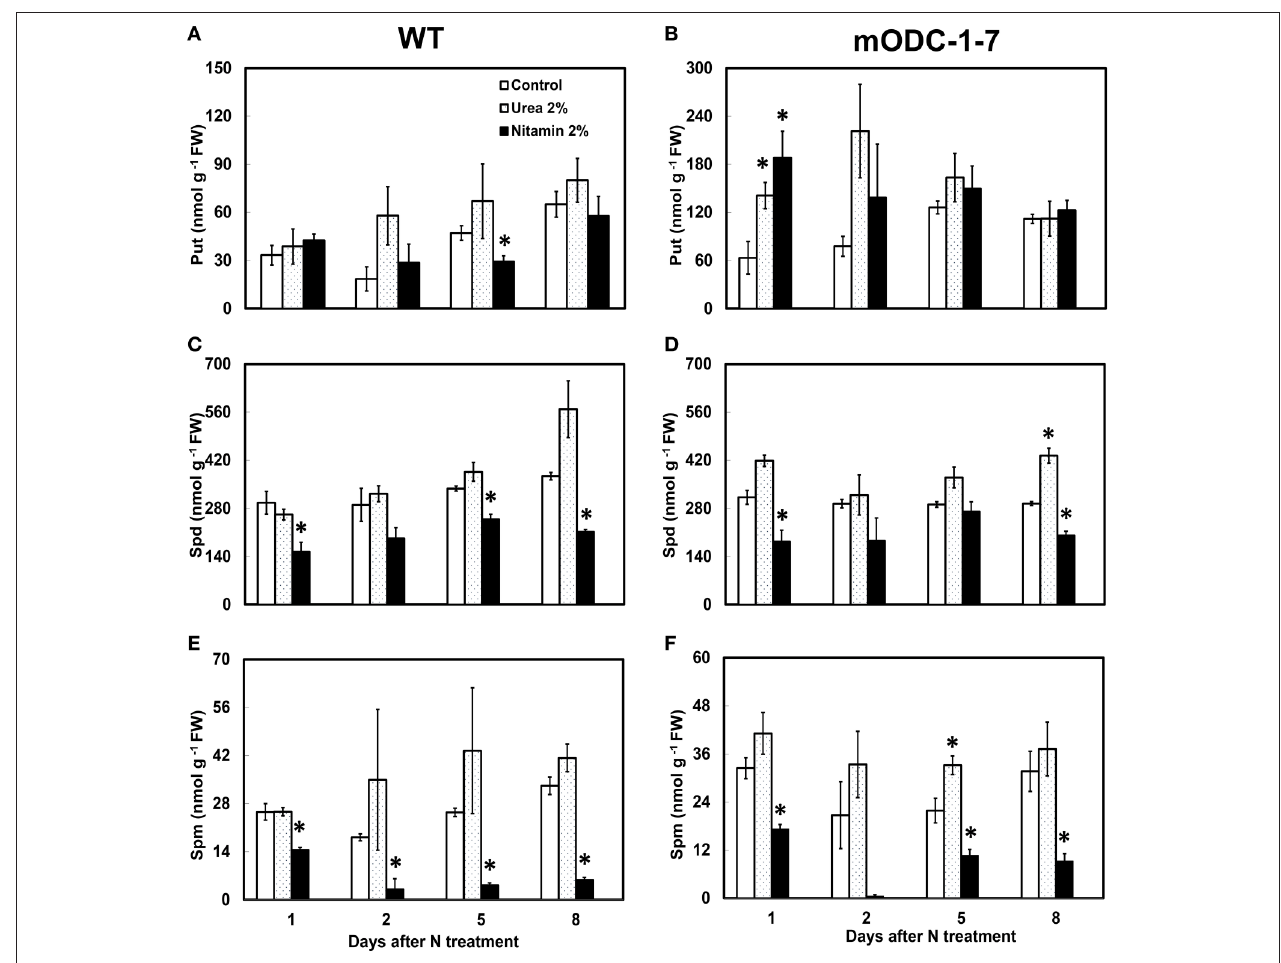
FIGURE 7 | Effect of foliar nitrogen treatments on PCA soluble polyamines in the rosette leaves of 6 week-old WT and 2x 35S ::m ODC Arabidopsis thaliana plants. Cellular concentrations of (A,B) putrescine, (C,D) spermidine, and (E,F) spermine. Data are mean of 3 ± SE. * Denotes significant difference between treatment and the corresponding control for each time period for WT and for m ODC transgenic plants ( P ≤